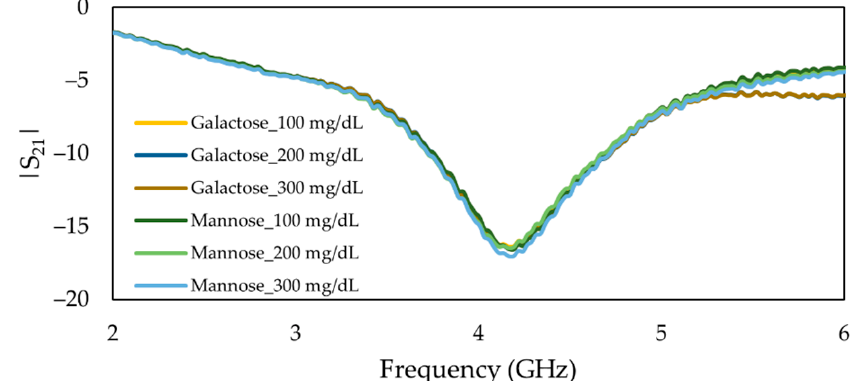
Figure 15. Measured frequency response of the insertion loss (S21) of main MIP-coated microwave- based stub biosensor exposed to mannose and galactose solutions ranging from 100 mg/dL to 300 mg/dL.